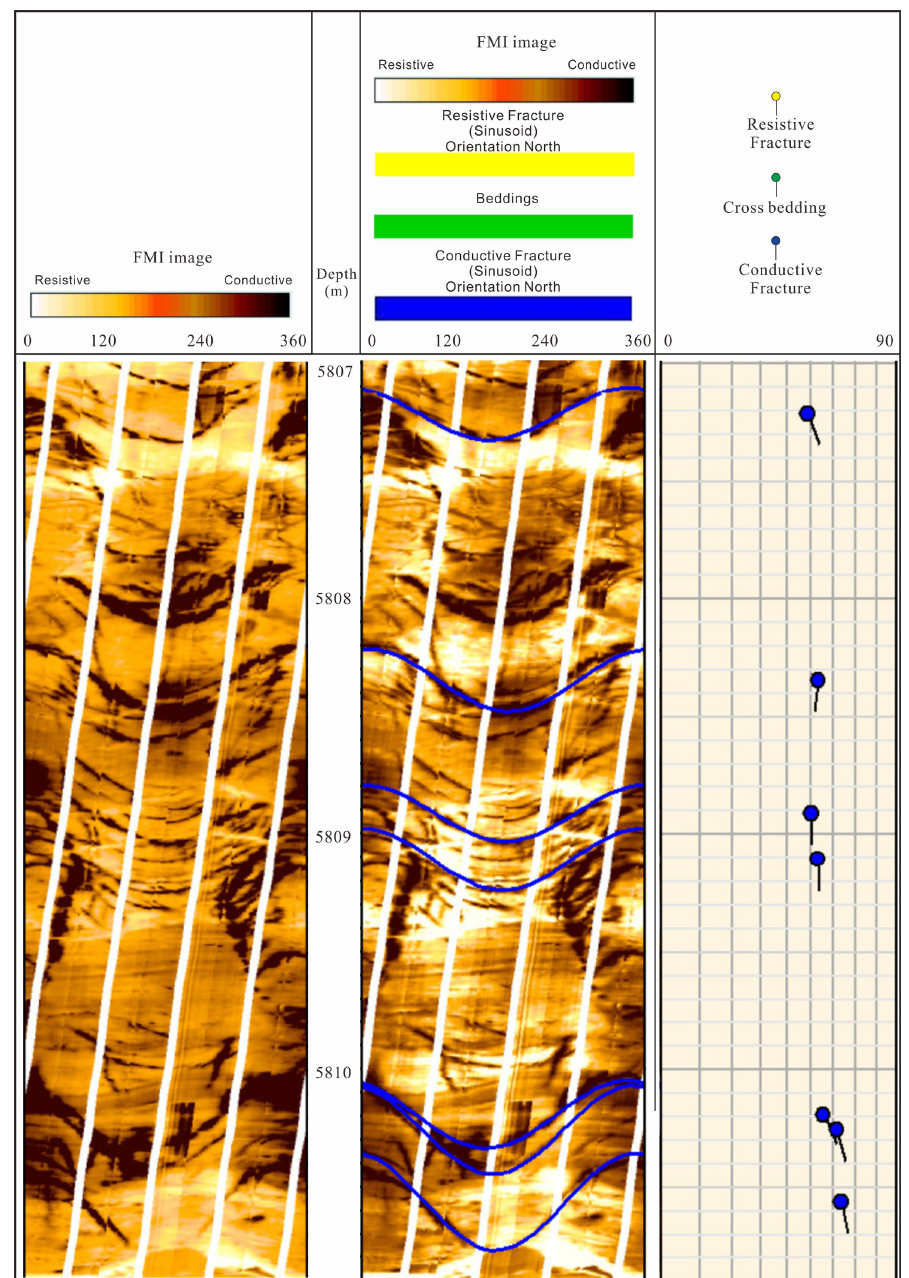
Figure 8. Fractures on the image logs picked out as dark sinusoidal